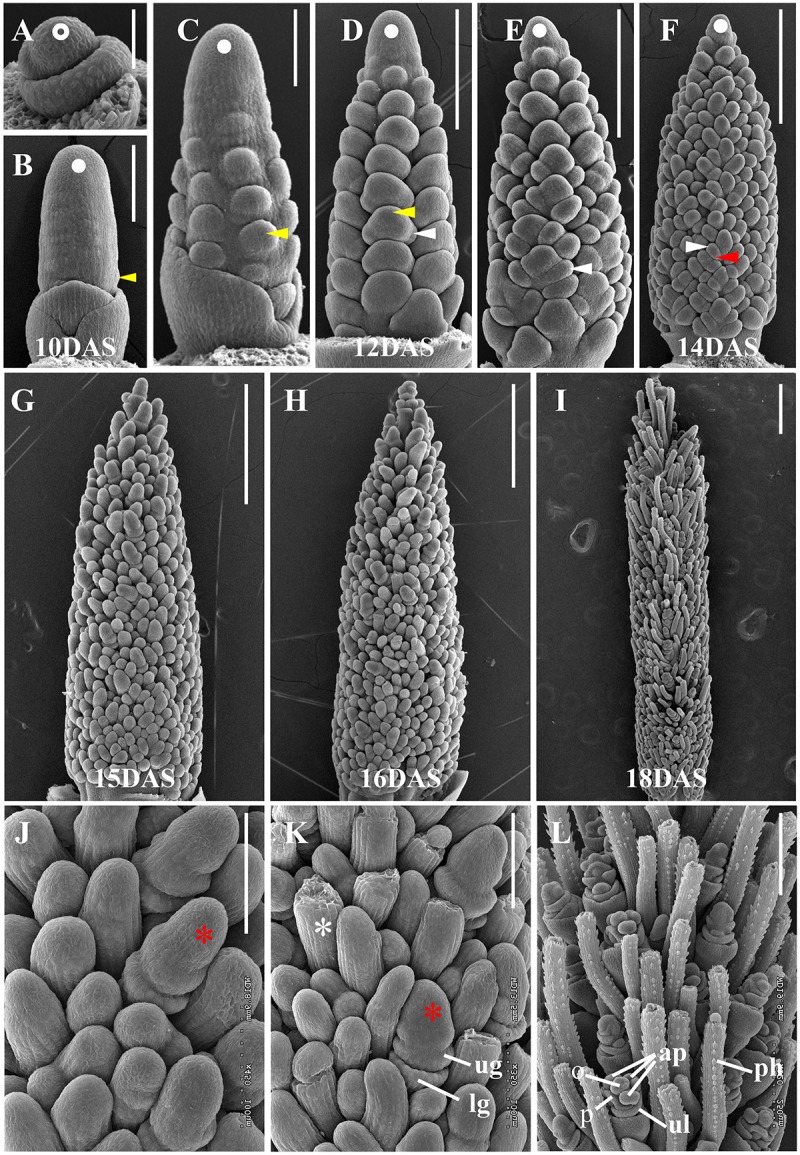
Key developmental stages of Setaria viridis inflorescence development by SEM. (A) At 8 DAS, the S. viridis SAM (white open circle) had not yet transitioned to reproductive development. (B) By 10 DAS, the SAM had transitioned to an indeterminate IM (white dot) and primary BMs (yellow arrow) were initiated. As development proceeds through (C) 11 DAS, (D) 12 DAS, (E) 13 DAS, and (F) 14 DAS stages, primary, secondary, and higher order branching was progressively initiated (white dot, IM; yellow arrow, primary BM; white arrow, secondary BM; red arrow, tertiary BM). (G, J) At 15 DAS, SMs (red asterisk) had begun to differentiate and by 16 DAS (H, K), were distinguishable from developing bristles (white asterisk) and initiated glume primordia (lg, lower glume; ug, upper glume). (I, L) At 18 DAS, bristles were elongated and developed prickle hairs (ph) and SMs further differentiated floral organs (ul, upper lemma; p, palea; ap, anther primordium; o, ovary). Developmental stages that were used for RNAseq-based transcript profiling are labeled. Scale bars = 50 μm in (A), 100 μm in (B, C, J, and K), 250 μm in (D–F and L), and 500 μm in (G–I).